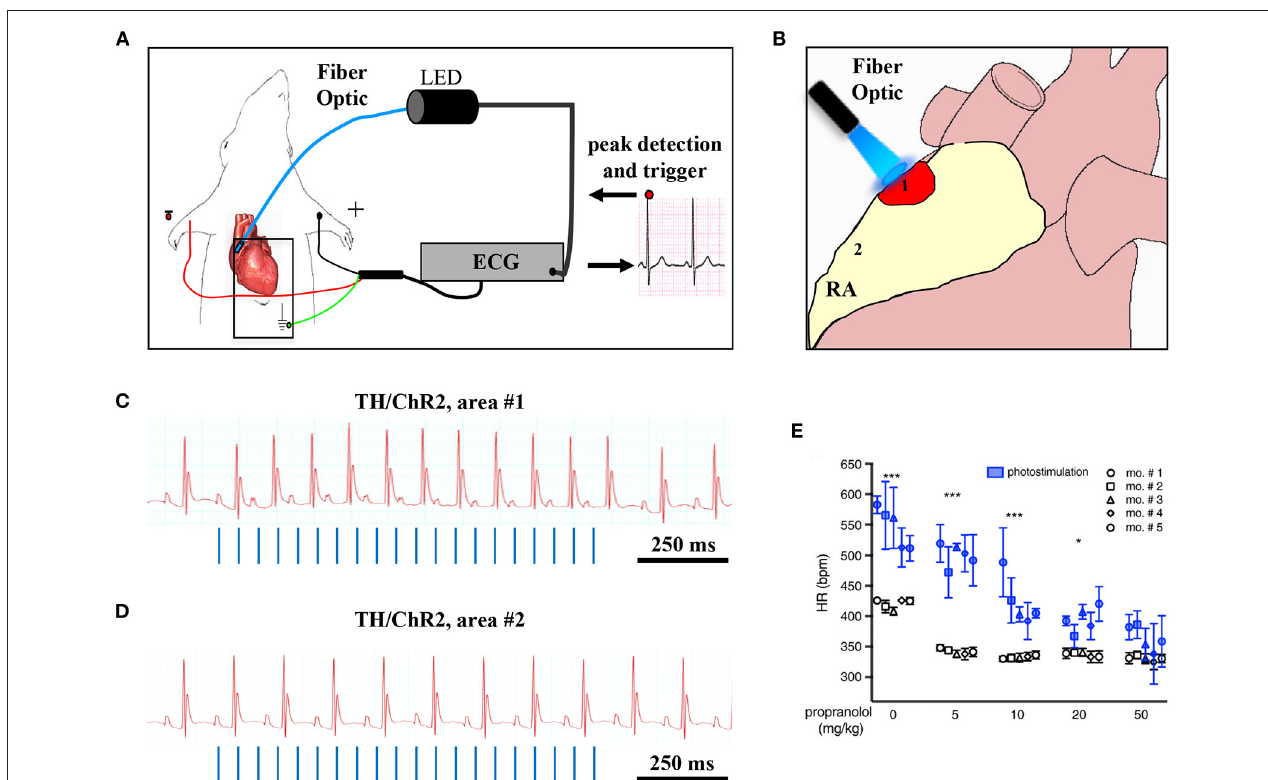
FIGURE 7 | Optogenetic assessment of neuro-cardiac coupling in vivo . (A) Schematic illustration of the neuronal optogenetic set up used for right atrium (RA) illumination in open chest anesthetized mice. (B) Representation of the different photostimulated atrial regions (areas#1–2). (C) Representative ECG trace of the optogenetic experiment, showing positive chronotropic response upon photoactivation (blue lines) of the RA area#1 in TH/ChR2 mice. (D) Representative ECG trace showing unchanged HR upon illumination of RA area#2. (E) Dose-effect analysis of the treatment with the β -AR antagonist, propranolol, on the chronotropic response to neuronal photostimulation. Blue symbols identify responses to photostimulation, while the white ones show the effects of systemically delivered NA (*** P < 0.001; * P < 0.05). Images modified with permission from Prando et al.